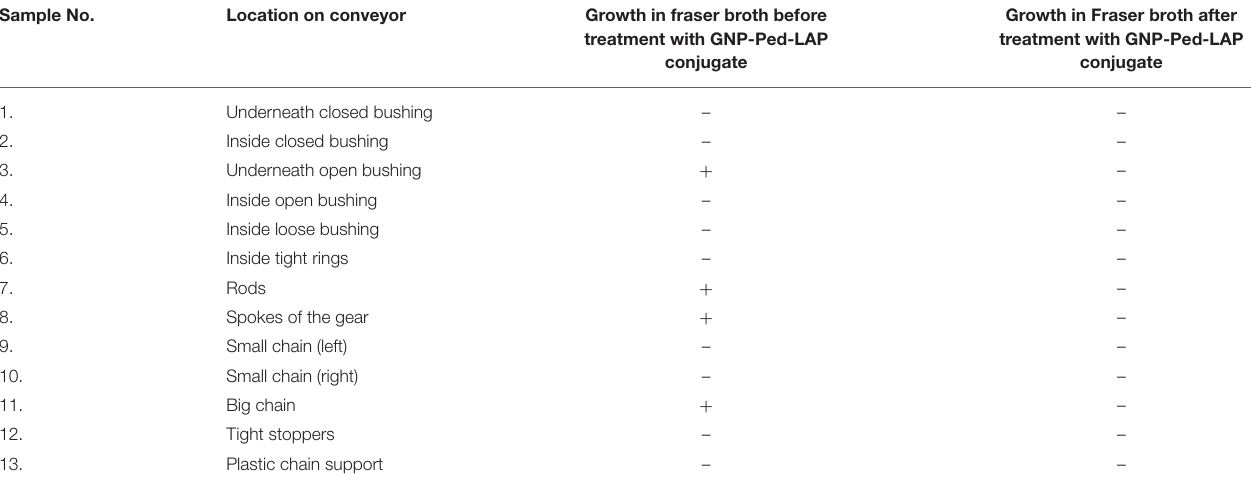
TABLE 2 | Surface decontamination of an operational conveyor model system using GNP-Ped-LAP conjugate. Sample